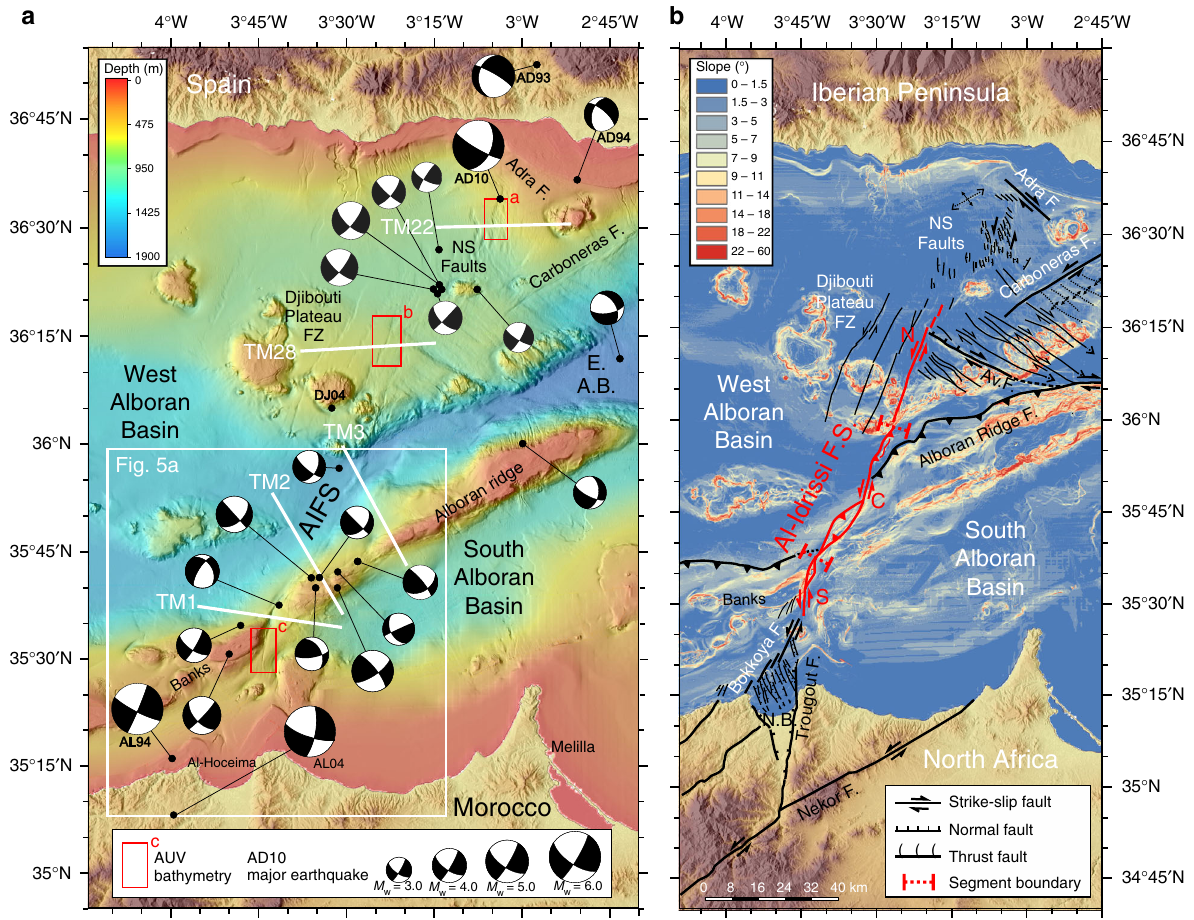
Fig. 2 Shipboard bathymetry, earthquake focal mechanisms and active faults. a Shipboard bathymetry and moment-tensor solutions for earthquakes that occurred in the area before the 2016 events. Major earthquakes of M w > 4.8 are noted: DJ04: Djibouti plateau 1804 15 ; AD10: Adra 1910 25 ; AD93 – 94: Adra series 1993 – 1994 15 ; AL94: Al-Hoceima 1994 9,10 ; AL04: Al-Hoceima 2004 11 . White lines locate the MCS pro fi les (Fig. 4). Red boxes locate Fig. 3a – c. EAB: East Alboran Basin. b The Al-Idrissi Fault System (in red) and related tectonic structures are overlaid on a slope map. AIFS North (N), Central (C) and South (S) segments are located on the